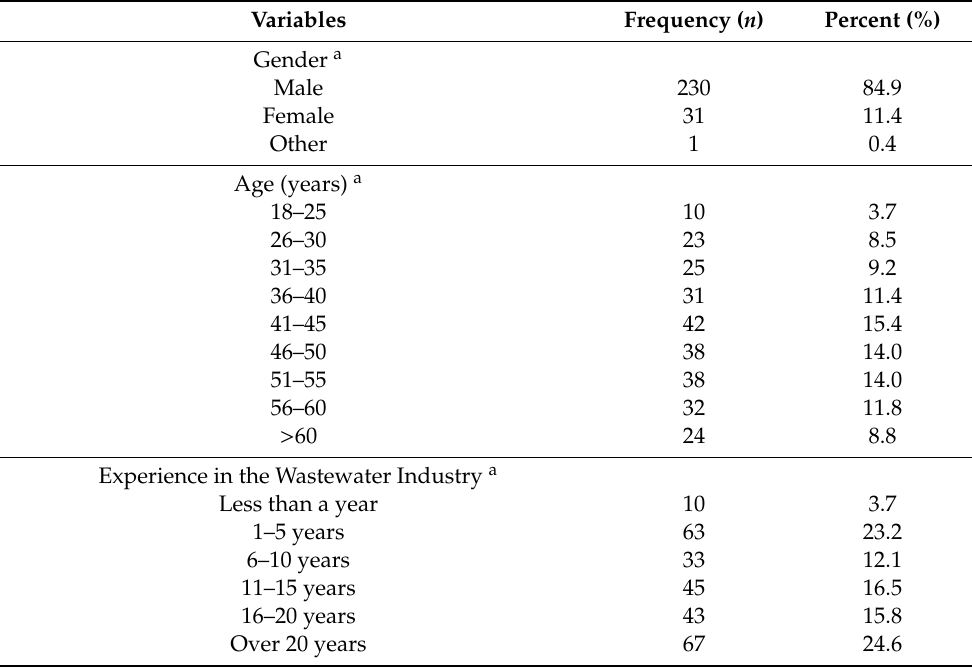
Table 1. Characteristics of the study